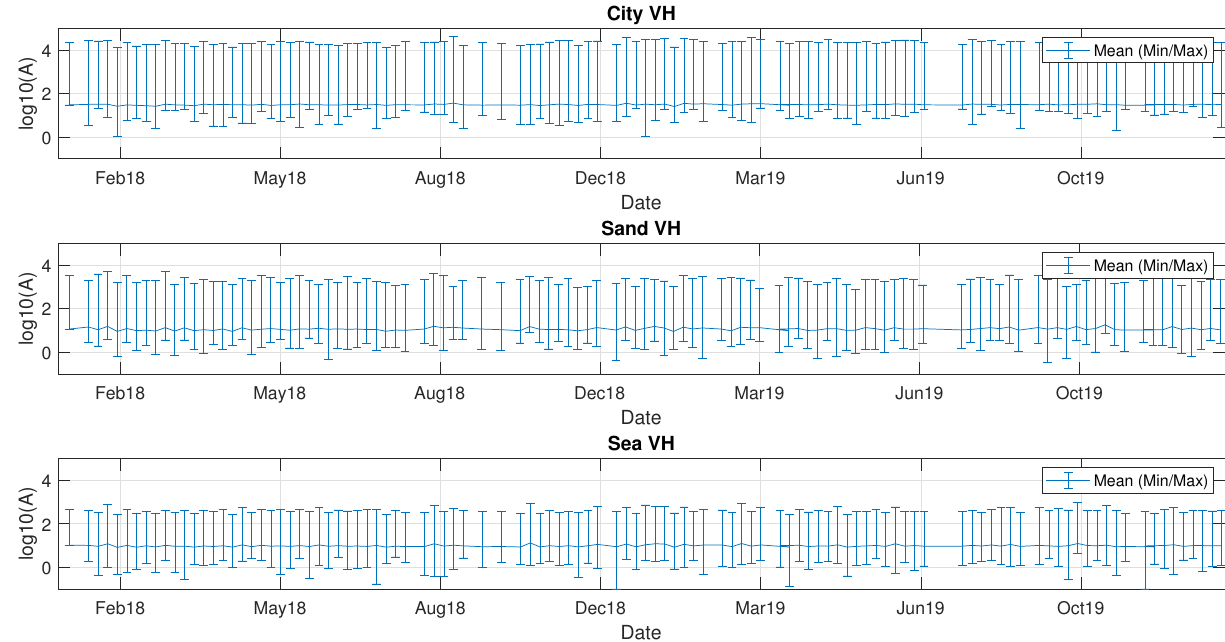
Figure 5. Comparison between ranges and mean amplitude values over 2 years for the city (first raw), sand (second raw), and sea (third raw) masks (VV polarization). The highest values occur for the city, which is also the area with the smallest mean amplitude variability over time. The maximum variability and the least mean values occur for the sea area, showing a decreasing trend of the amplitude moving from the city towards the sea. High variability both in the range and in the mean values also occurs in the sandy area. This can be due to anthropogenic activity, weather conditions, and tidal conditions.